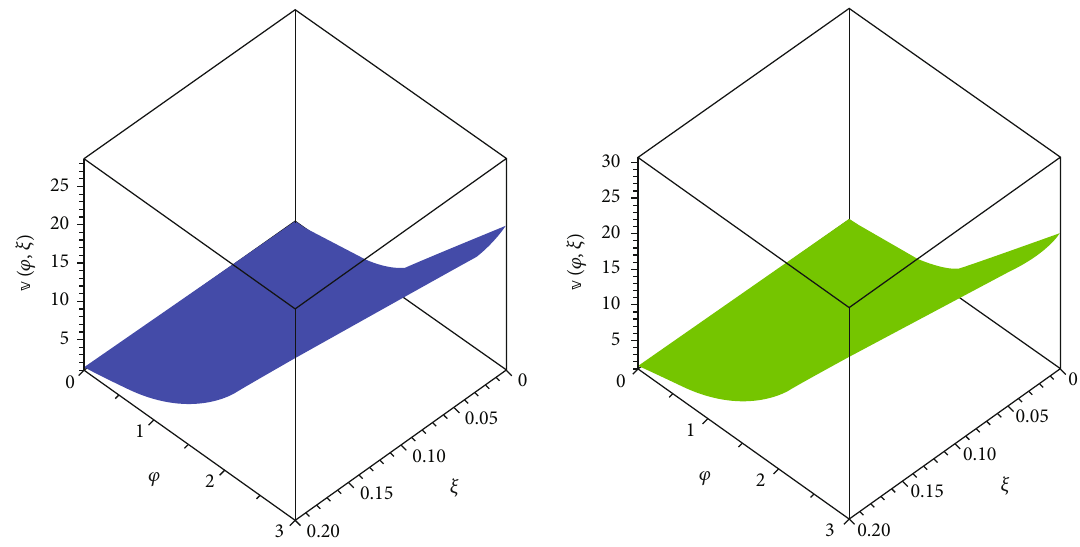
Figure 8: The di ff erent fractional-order of ℘ = 0 : 6 and 0.4 of Example